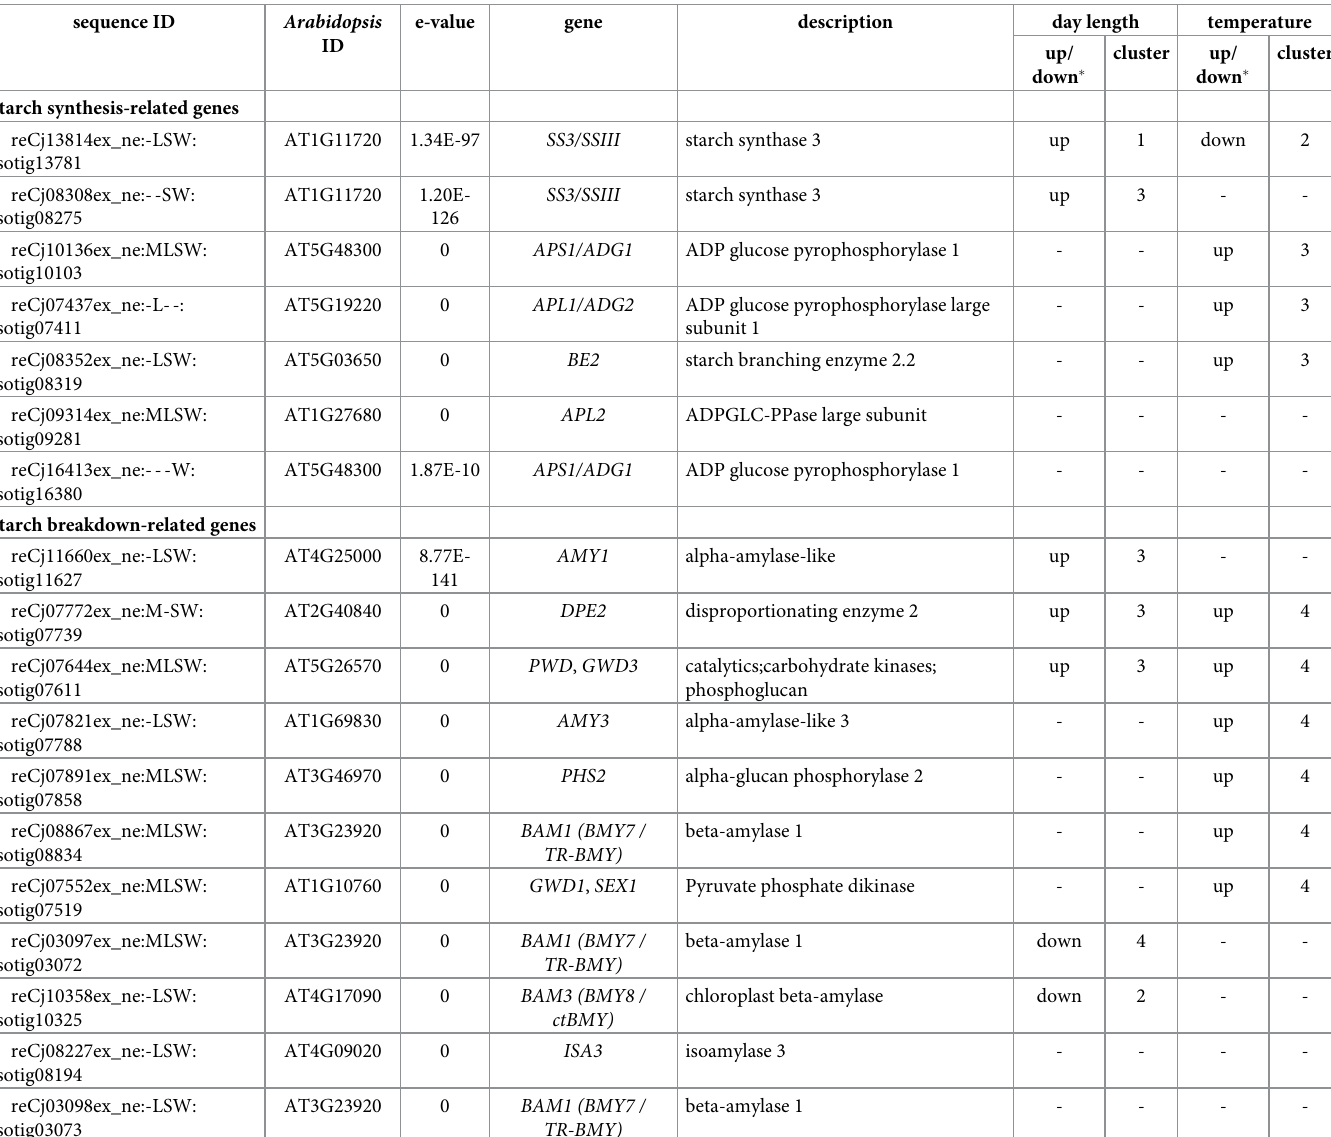
Table 5. Effects of day length and temperature on genes related to starch synthesis and degradation. sequence